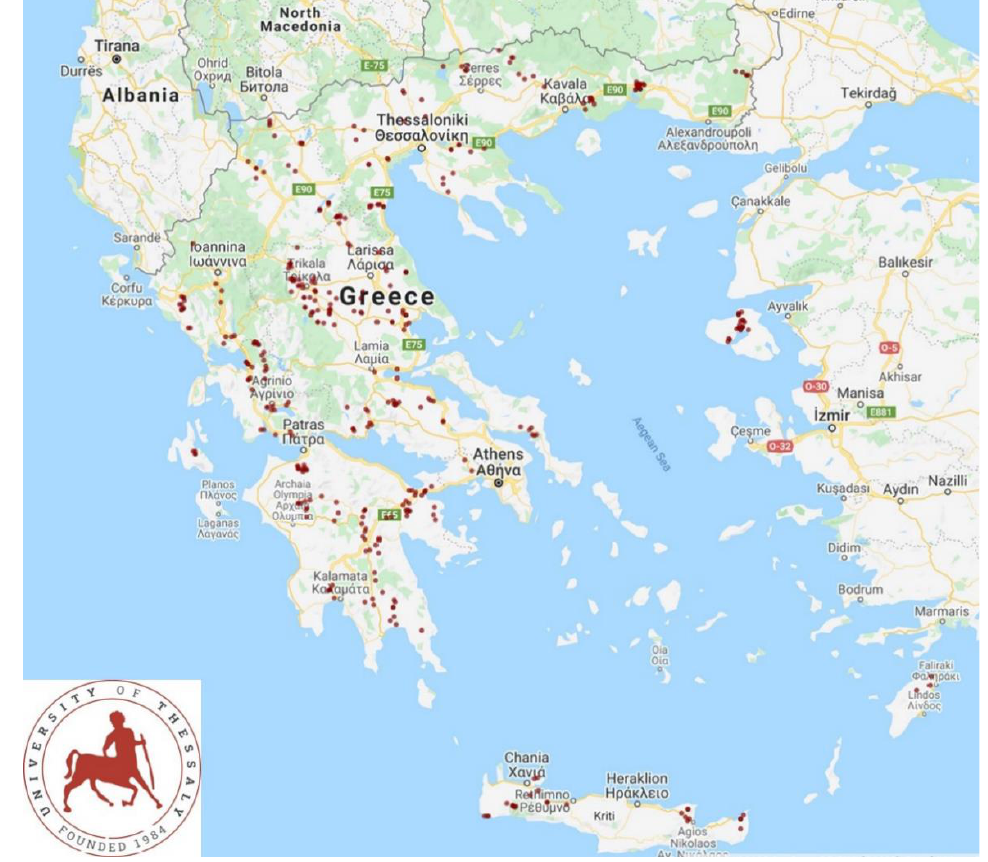
Figure 1. Map presenting locations of the 444 small ruminant farms throughout Greece, which were visited to record details on vaccination schedules and procedures.